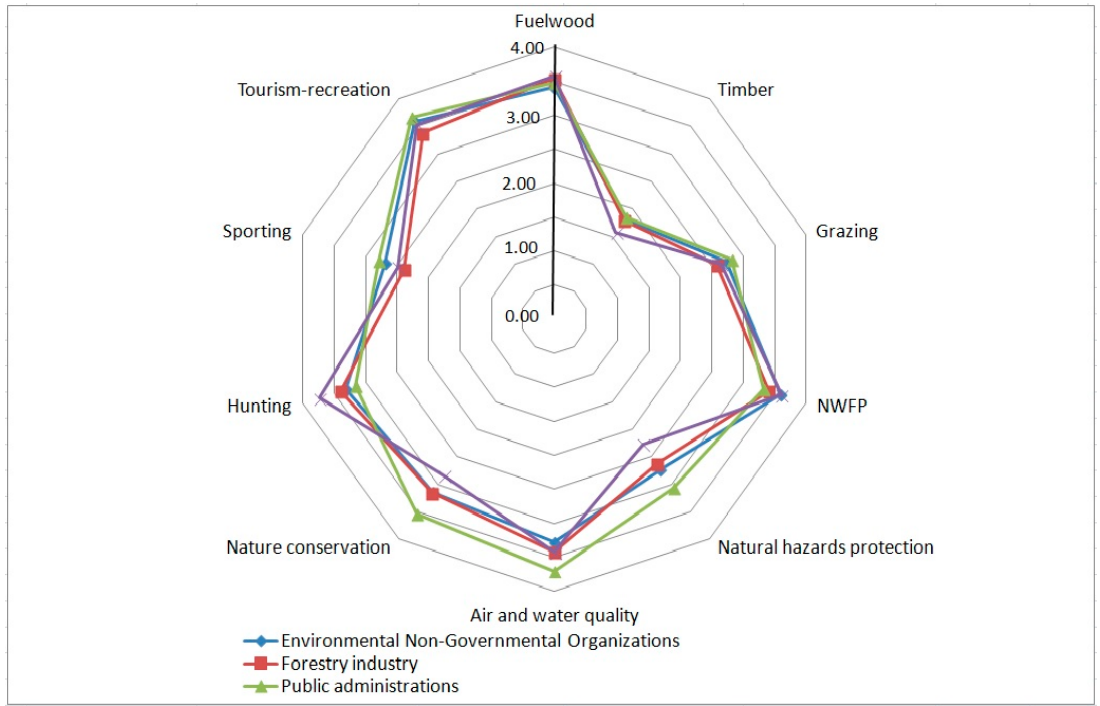
Figure 2. Stakeholders’ preferences for ten ecosystem services (ES) by group of interest (mean value).